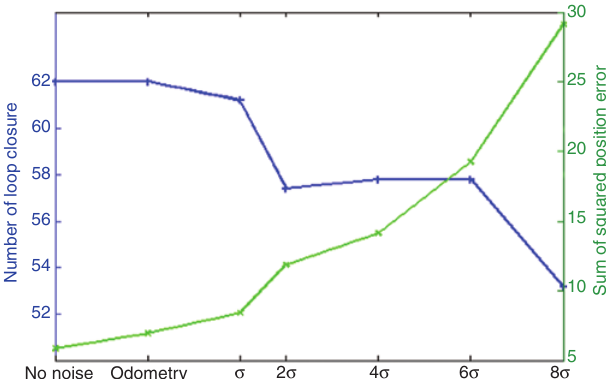
Figure 17. Number of Loop Closures Detected (Blue) and Sum of Squared Differences between Reference Path and Path Follow- ing (Green) for Several Levels of Simulated Odometry Noise.